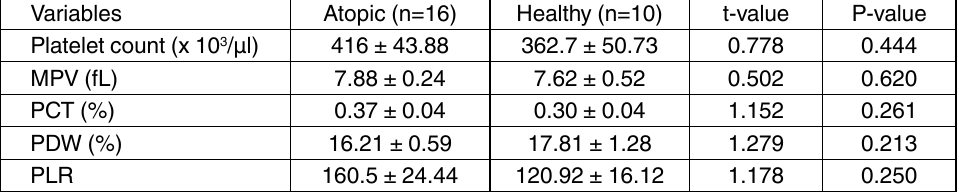
table 4. Correlation of PLR and NLR